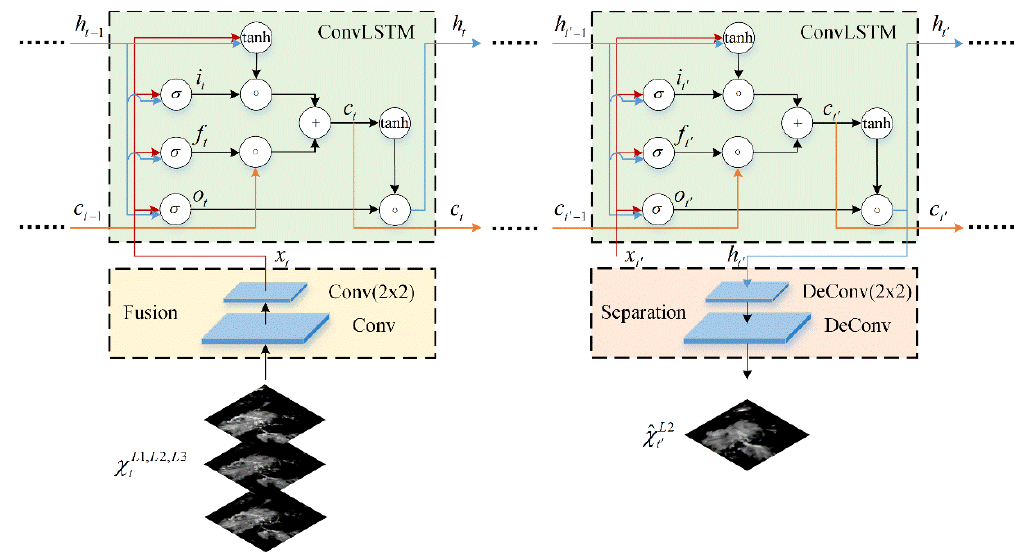
Figure 2. The architecture of the Multi-Level Correlation Long Short-Term Memory (MLC-LSTM). The fusion module converts the input three-level echoes into feature space and fuses the echo features separated at different levels together. It models the redistribution of echo intensity which is caused by the spatiotemporal atmospheric movements at one timestep. We implement the fusion module with two convolutional layers, the first convolutional layer with stride 1 × 1 is used to map the input echoes from the image space to feature space, and the second layer with stride 2 × 2 is applied to integrate features from different levels. Both of the two layers are followed by the rectified linear unit (ReLU) activation function.